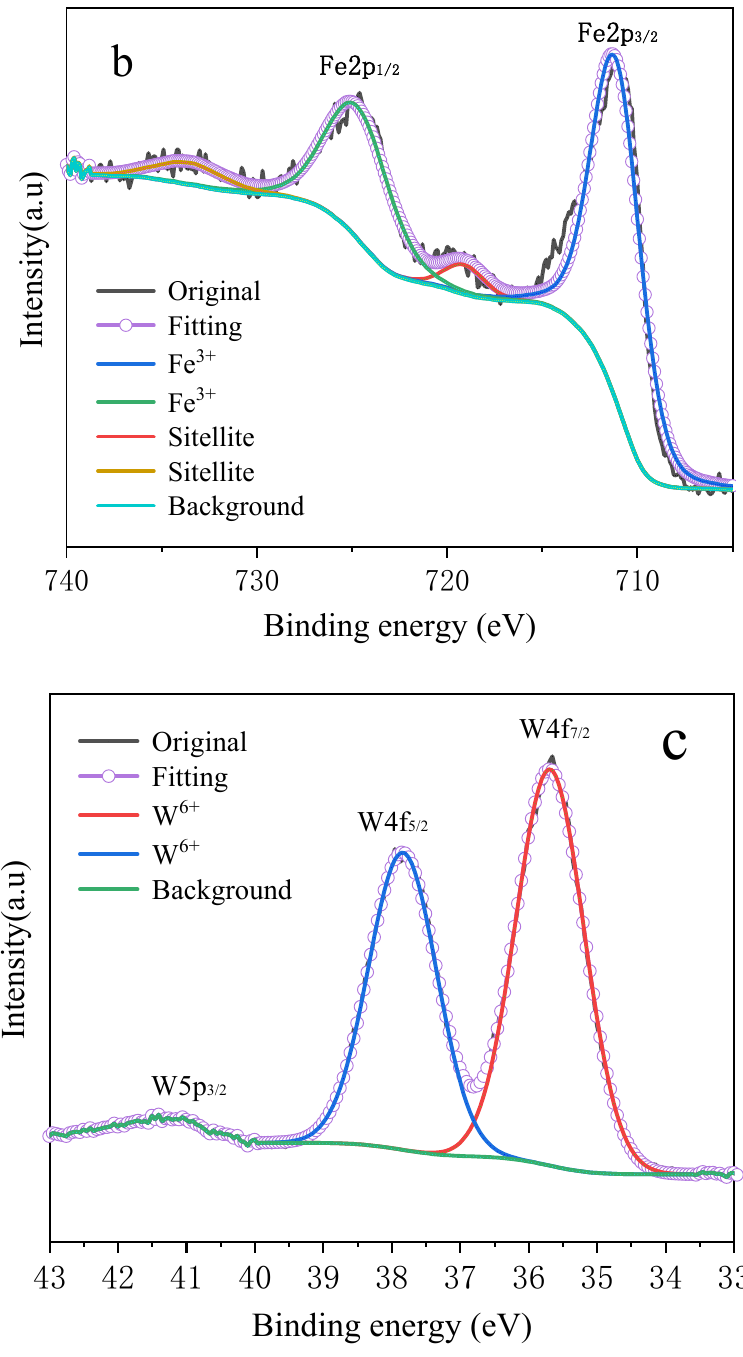
Figure 2. XPS spectra of ( a ) γ -Fe 2 O 3 /WO 3 ·0.5H 2 O; ( b ) Fe 2p; ( c ) W 4f.